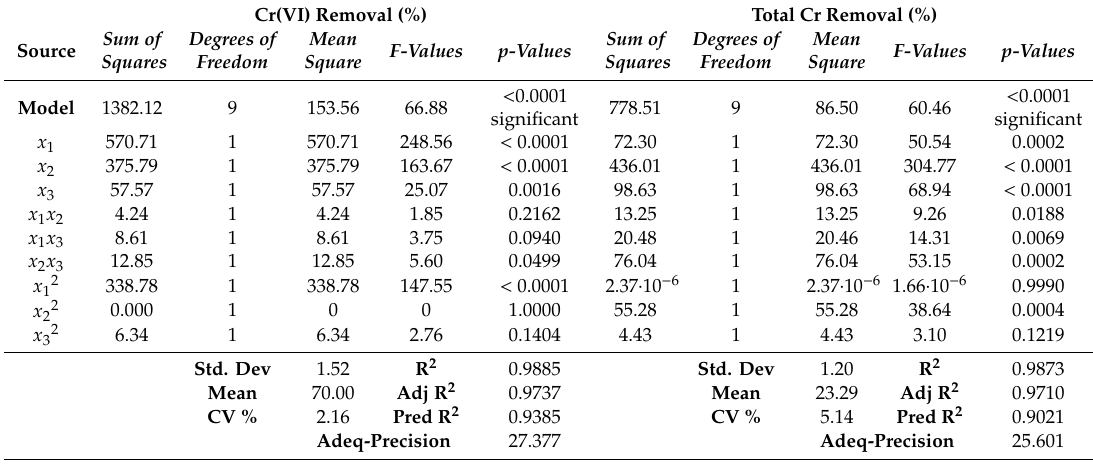
Table 3. ANOVA evaluation for both Cr(VI) and total Cr removal response surface quadratic